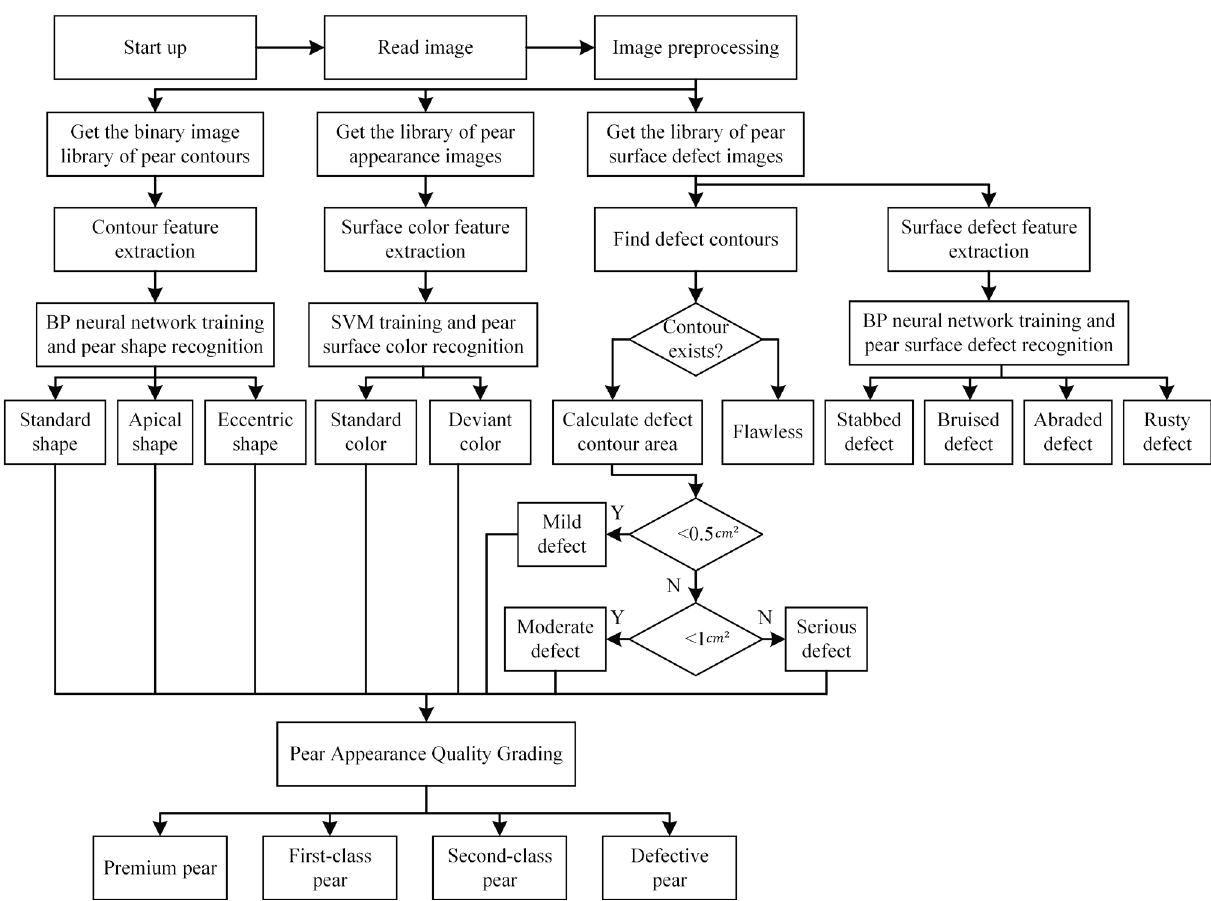
Figure 14. Detection flow chart. Table 3. The number of samples in the corresponding categories of grading indicators.